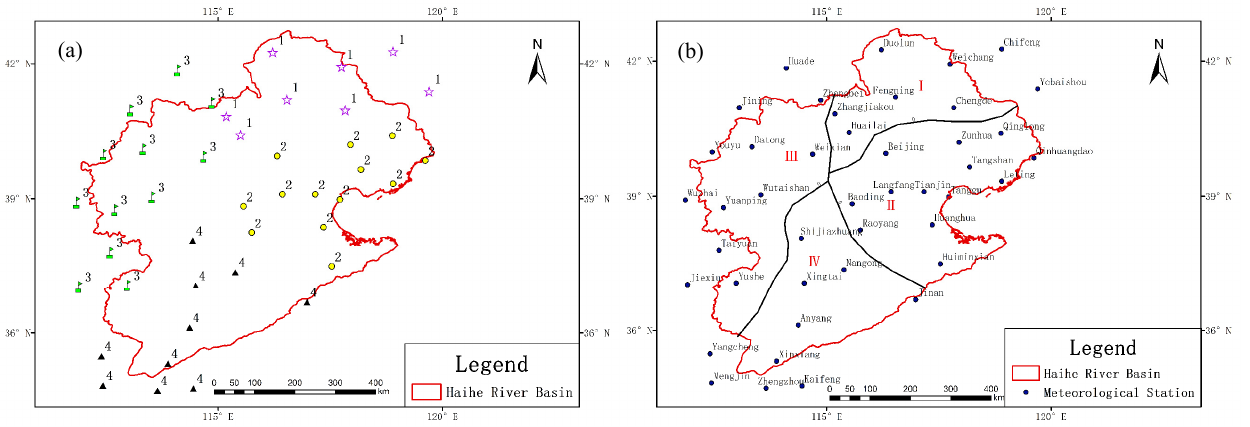
Figure 2. K-means clustering results and zones of the Haihe River Basin ( a ) K-means clustering results and spatial distribution for the Haihe River Basin. ( b ) Division zones of Haihe River Basin.